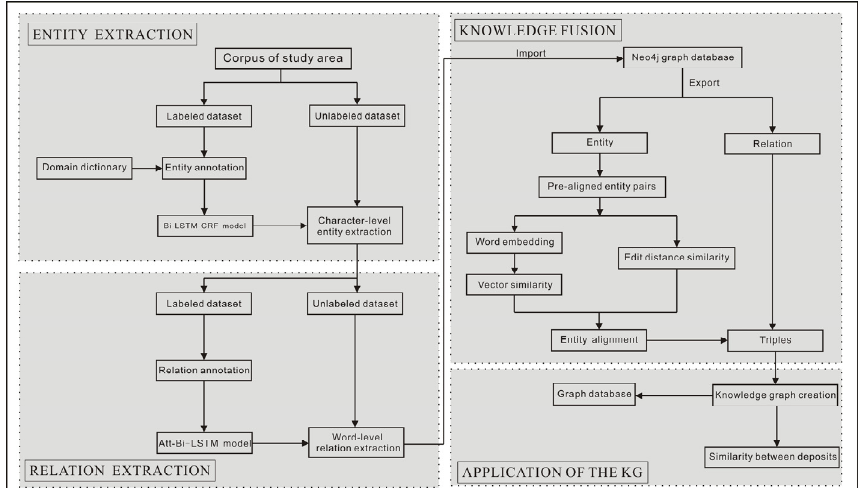
Figure 4. The KG construction framework.